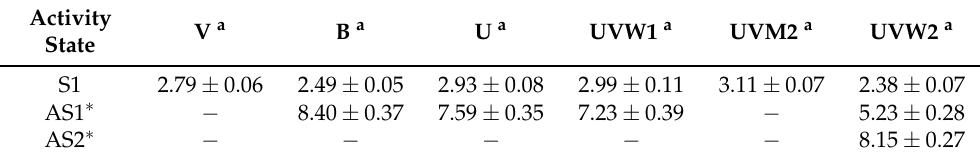
Table 4. Swift -UVOT results for different activity states.